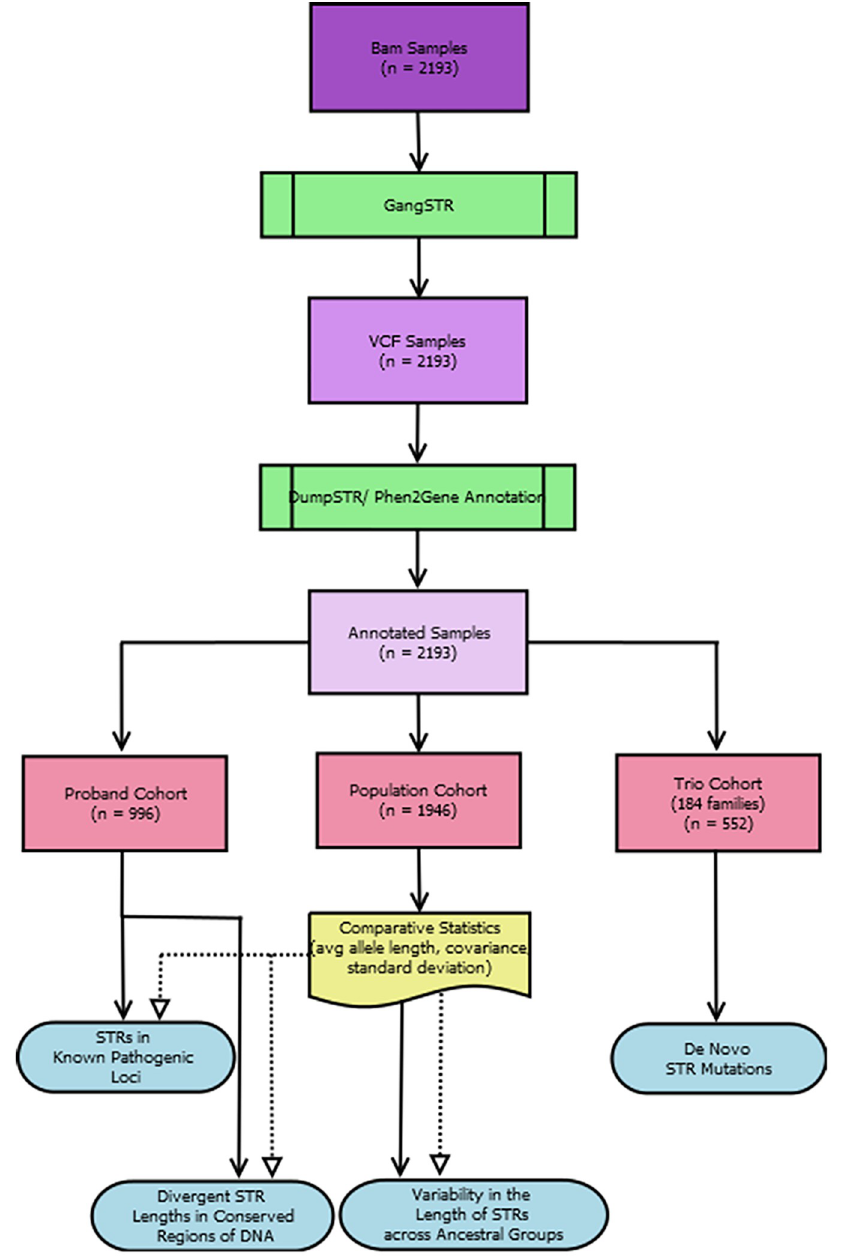
Fig 2. Dataset workflow: Bam samples were processed through GangSTR, filtered by DumpSTR, annotated by Casandra/GeneRanks, then broken out into the Population cohort, proband cohort, and Trio